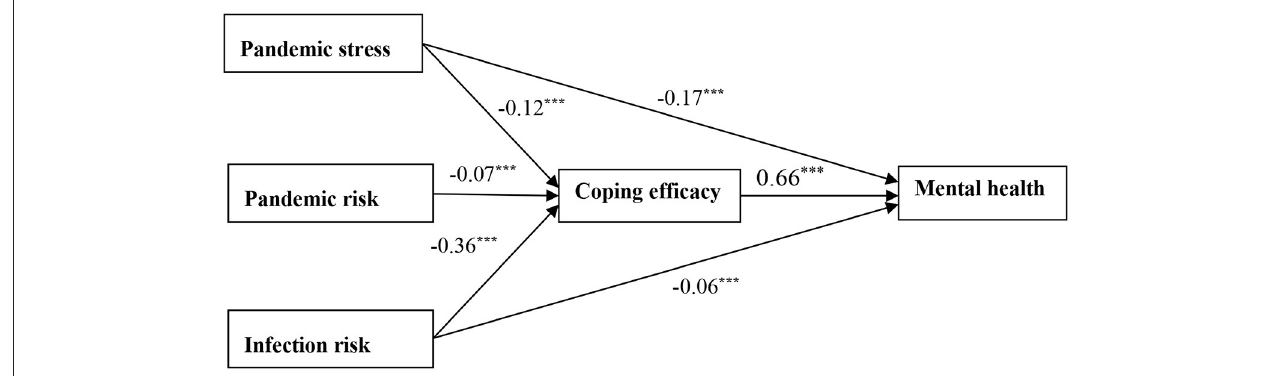
FIGURE 2 | Relationship between pandemic stress, risk perception, coping efficacy, and mental health. *** p <